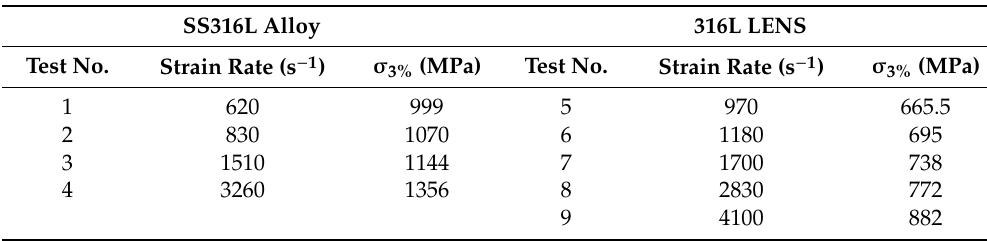
Table 4. Plastic flow stress for 3% strain of the 316L